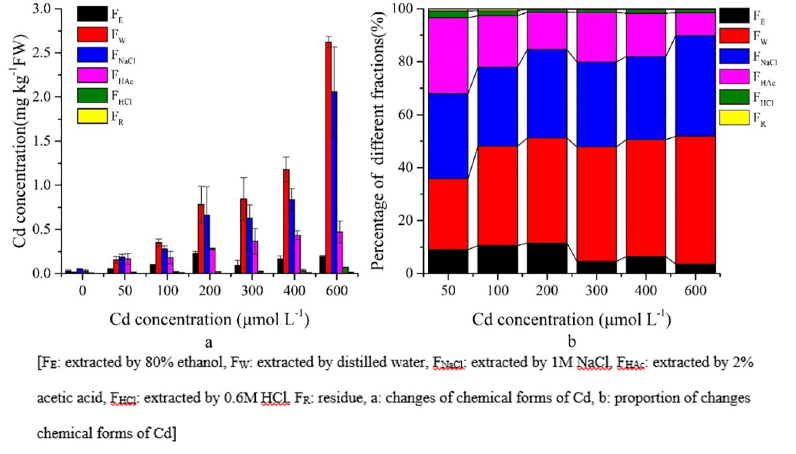
Fig 6. Chemical forms of Cd and proportions in S . portulacastrum